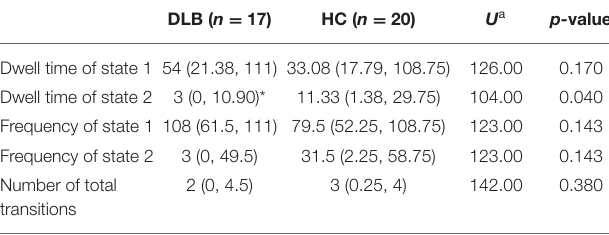
TABLE 2 | Clustering indexes of each group.